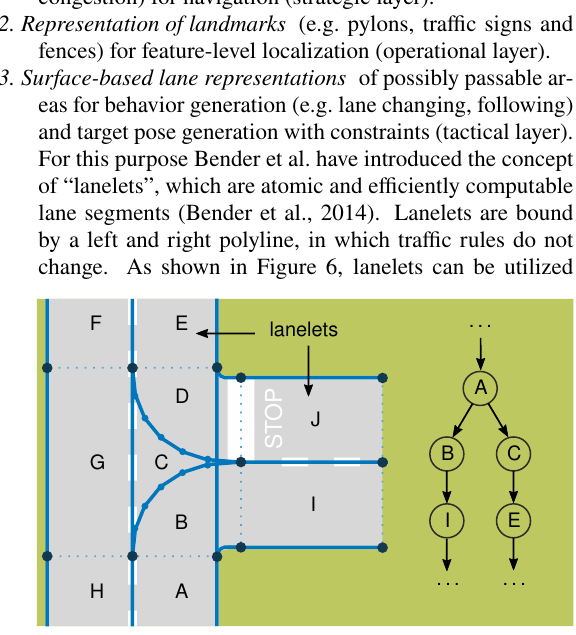
Figure 6. Surface-based representation as lanelets of a road crossing for lane-level navigation. Beil and Kolbe have proposed a similar approach for a refined transportation model in CityGML (Beil and Kolbe, 2017). 4. Traffic rule information by either attributing or preferably ref- erencing traffic infrastructure objects (e.g. traffic signs, traf- fic lights) to their applicable lanes or stopping lines for